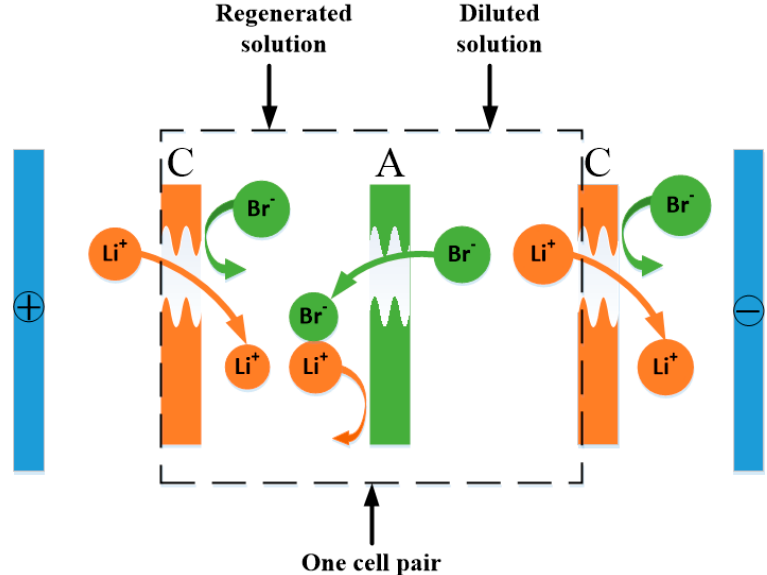
Figure 1. Schematic diagram of electrodialyzer.